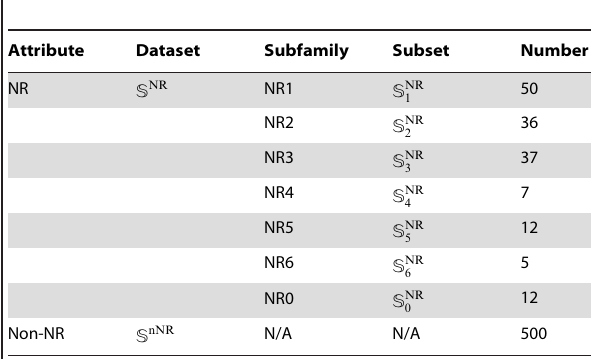
Table 1. Breakdown of the benchmark dataset S (cf. Eq. 1 ) used in this